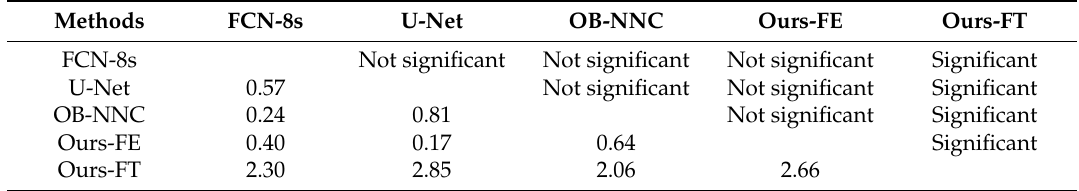
Table 5. Z-test for a 95% confidence level between methods using conventional OBIA, FCN-8s, U-Net, and our